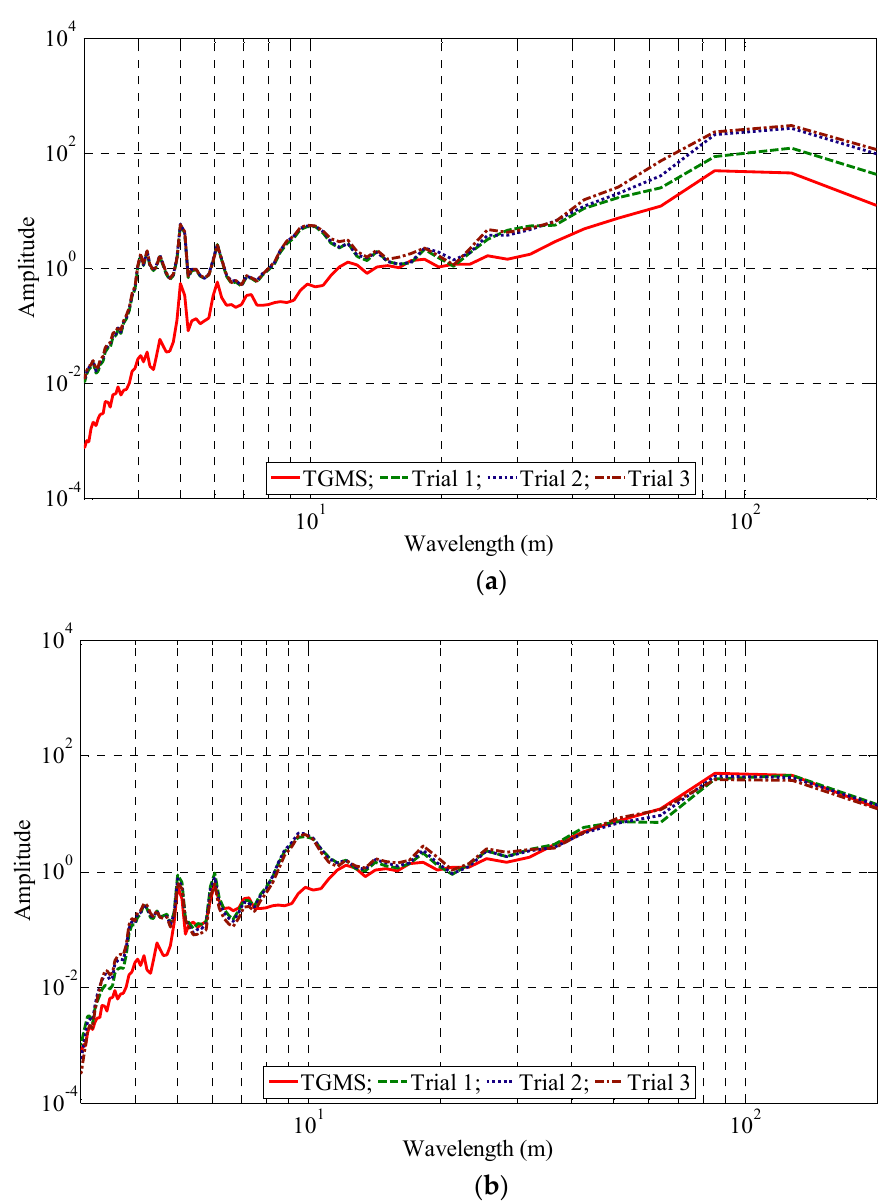
Figure 13. Estimation of vertical track irregularities in the wavelength domain: ( a ) axle box-mounted accelerometer; ( b ) bogie-mounted accelerometer.